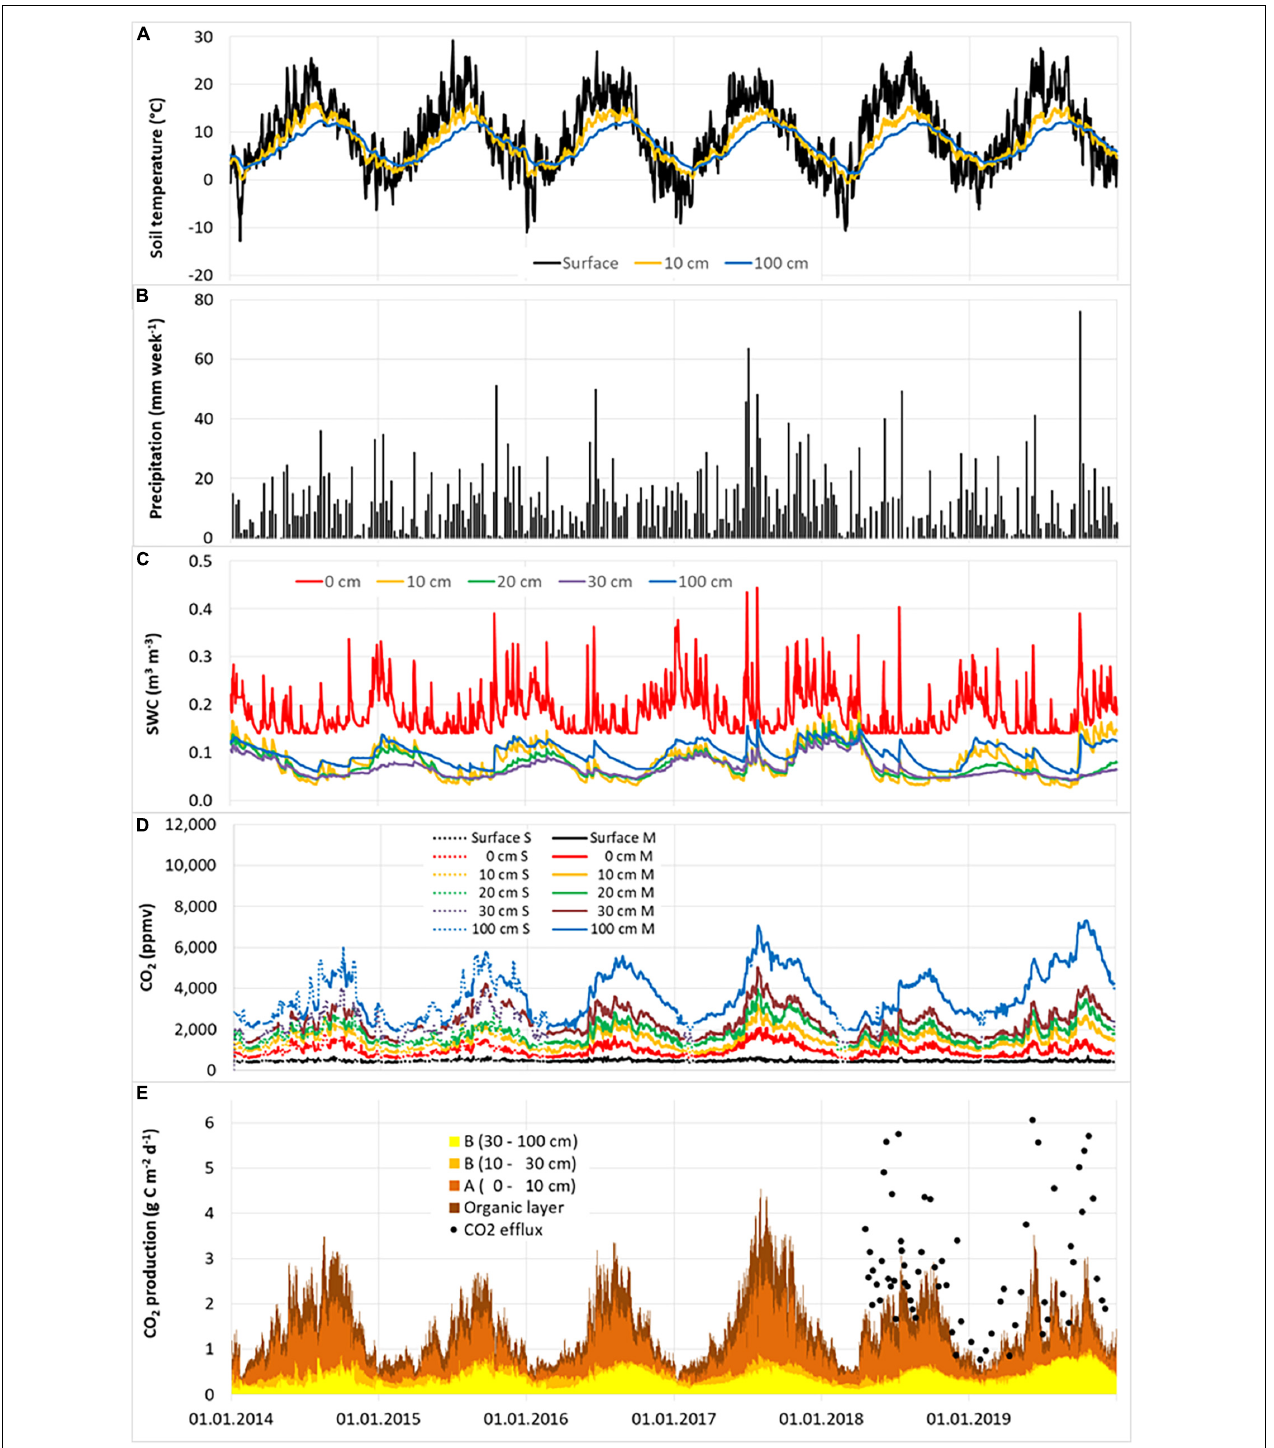
FIGURE 2 | Weekly precipitation total (B) and daily averages of soil temperature (A) , soil water content (SWC) (C) , measured (solid lines) and gap-filled (dotted lines) soil CO 2 concentration (D) , and soil CO 2 production rate, including CO 2 efflux from chamber measurements (E) at different soil depths at the pine site for the years 2014–2019. Total of CO 2 production over all the soil layers corresponds to the CO 2 efflux from the soil surface. Note that the measurement refers to the respective time of the day, while the calculated values represent daily averages. For this reason, part of the deviations between measured and calculated efflux rates is due to the deviating time scale.